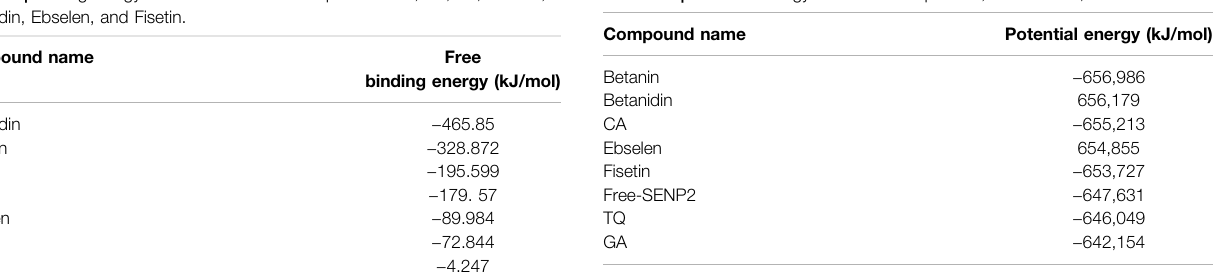
TABLE 4 | Potential energy of natural compounds, free-SENP2, and